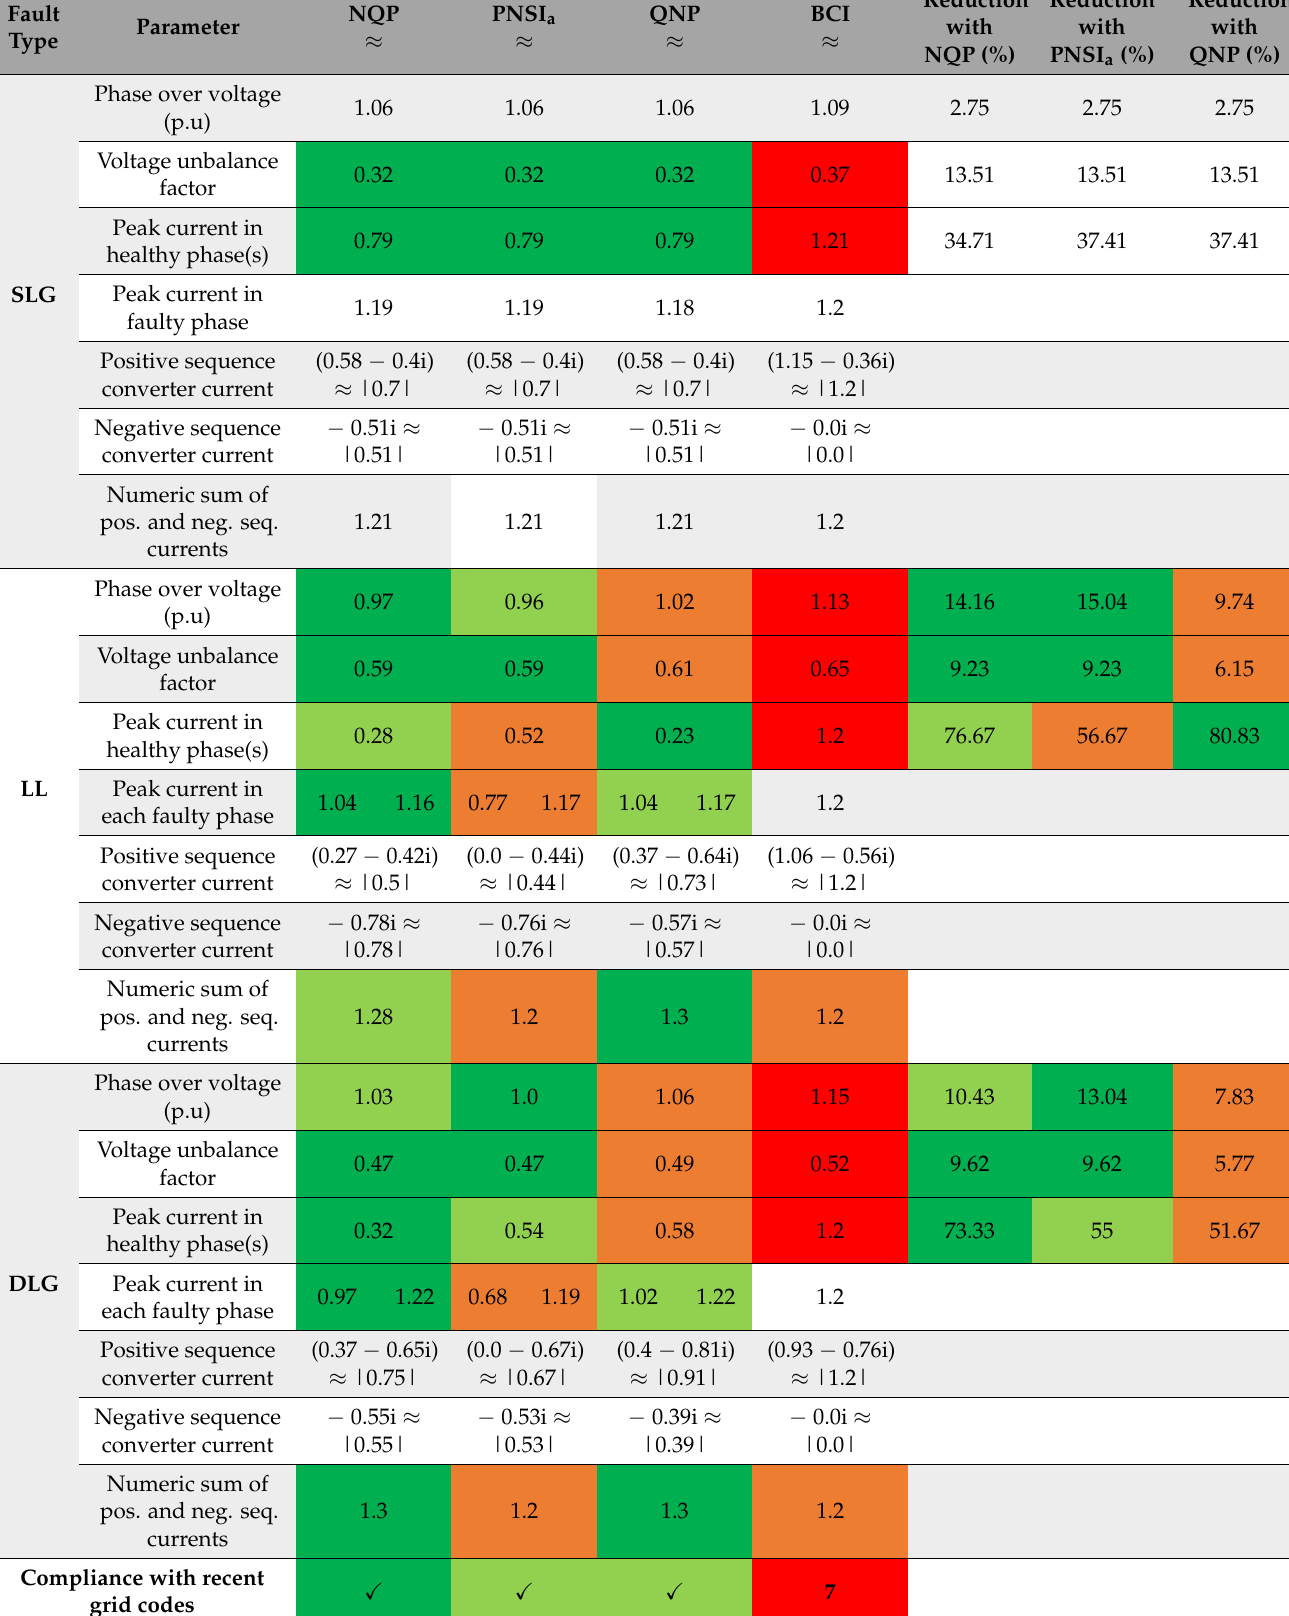
Table 2. Comparison of Control